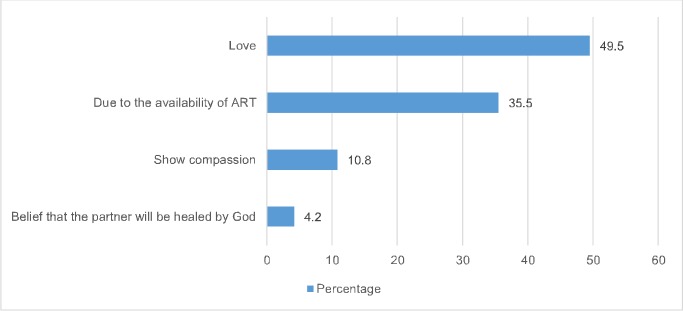
Reasons for marrying an HIV positive partner (n = 380)1.Note:
1A total of 380 individuals indicated that they will marry an HIV positive spouse. Percentages are weighted, and the total may sum up to more than 100% as multiple responses were permissible.